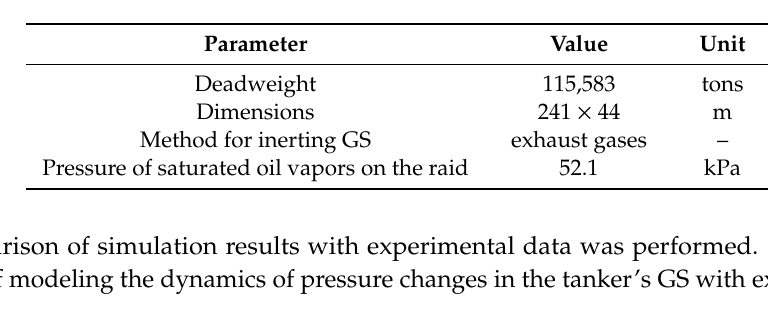
Figure 5. General view of the SOPHIESCHULTE tanker. Table 1. Technical characteristics of the SOPHIE SCHULTE tanker.